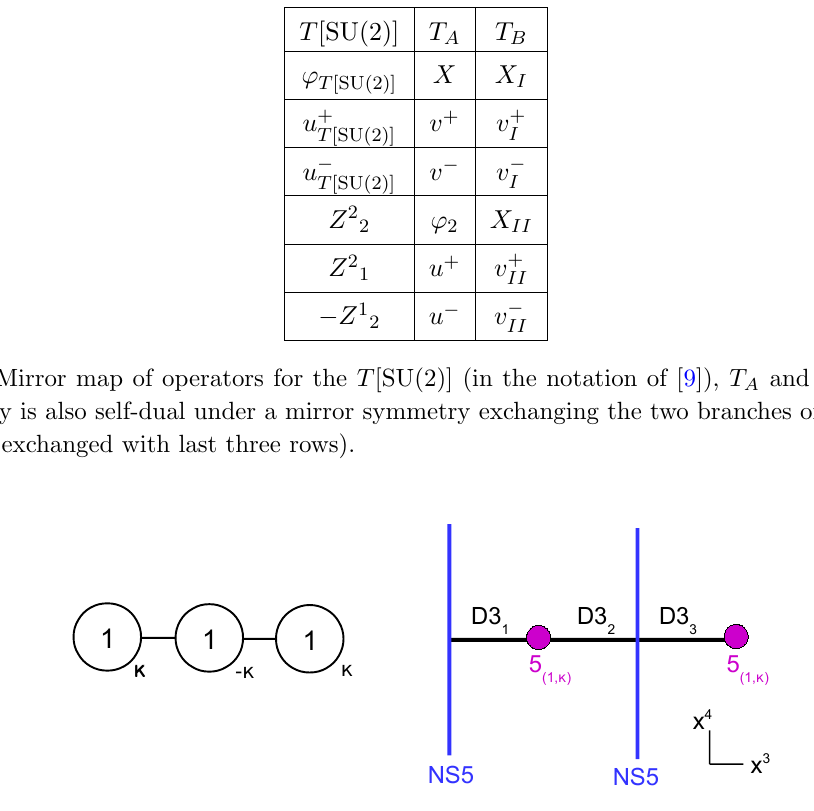
Figure 14 . Quiver diagram and brane realization of the U(1) (cid:20) (cid:2) U(1) (cid:0) (cid:20) (cid:2) U(1) (cid:20)